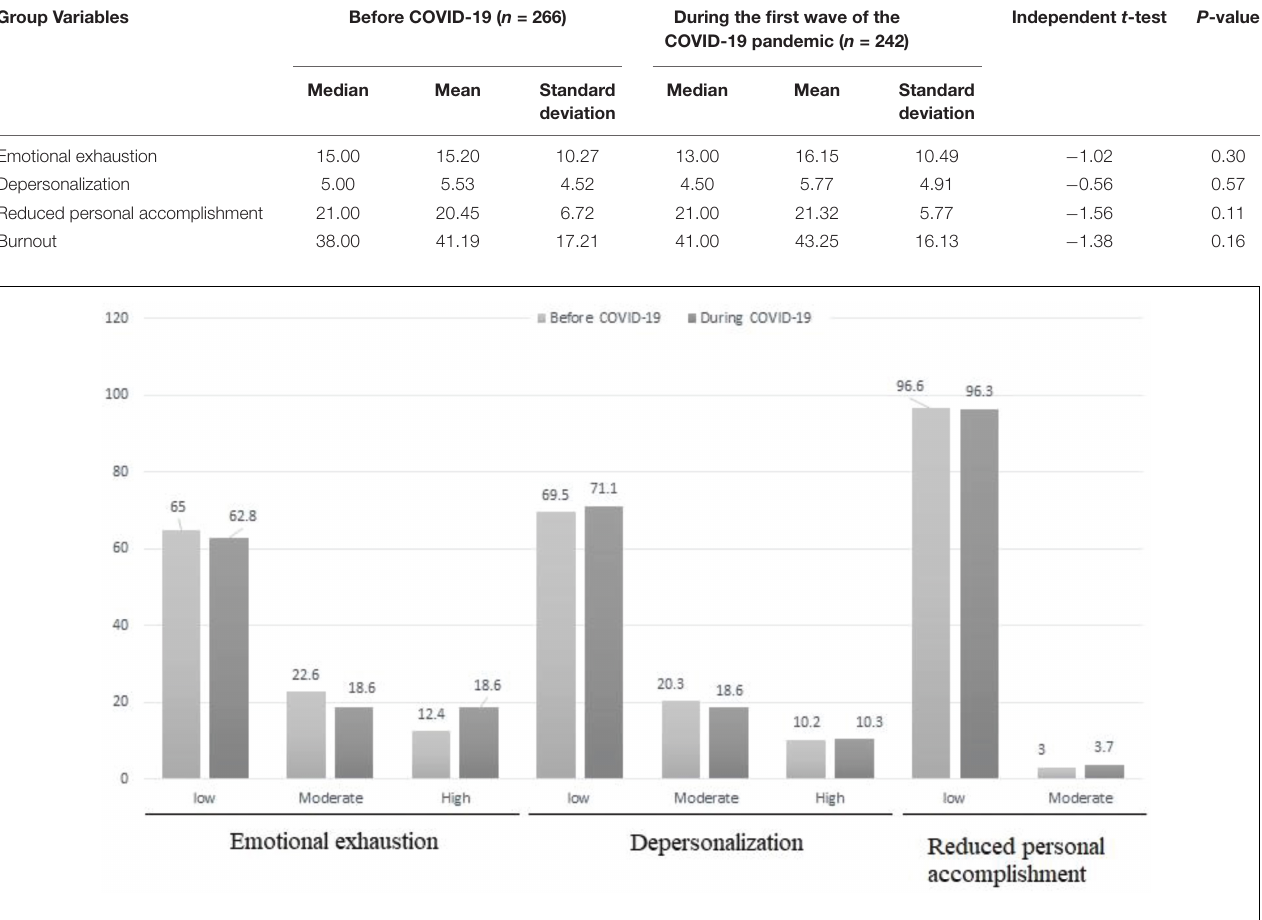
FIGURE 1 | The comparison of the level of burnout score before and during the first wave of the COVID-19 pandemic.